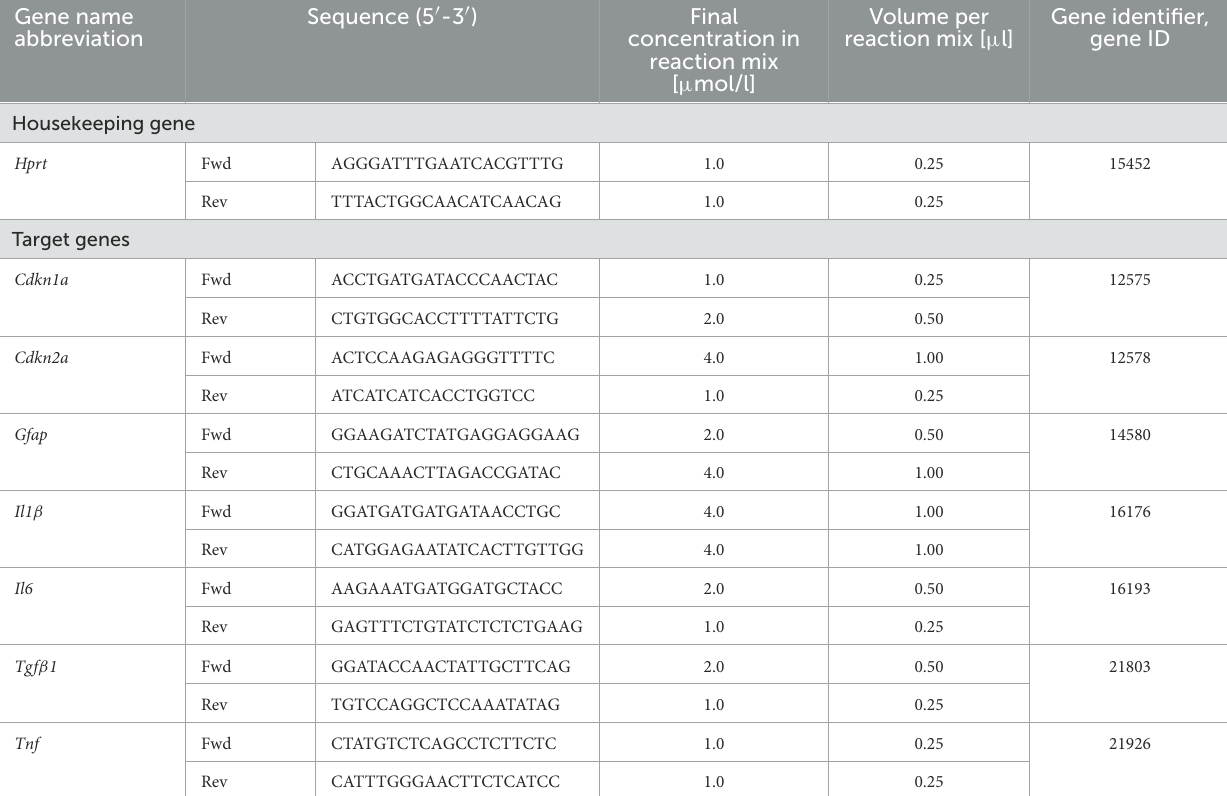
TABLE 4 Primers for